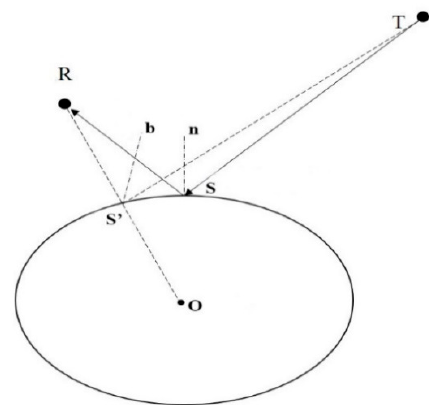
Figure 1. Geometry of the GNSS-R observation system.